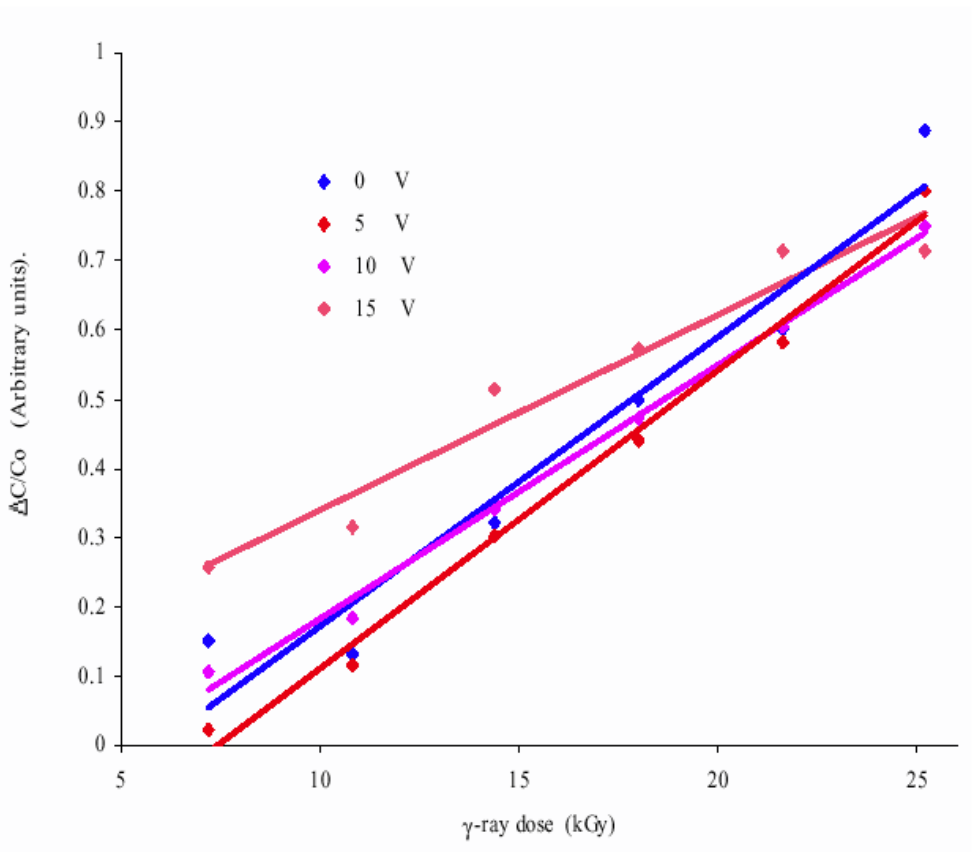
and γ -ray dose at different o